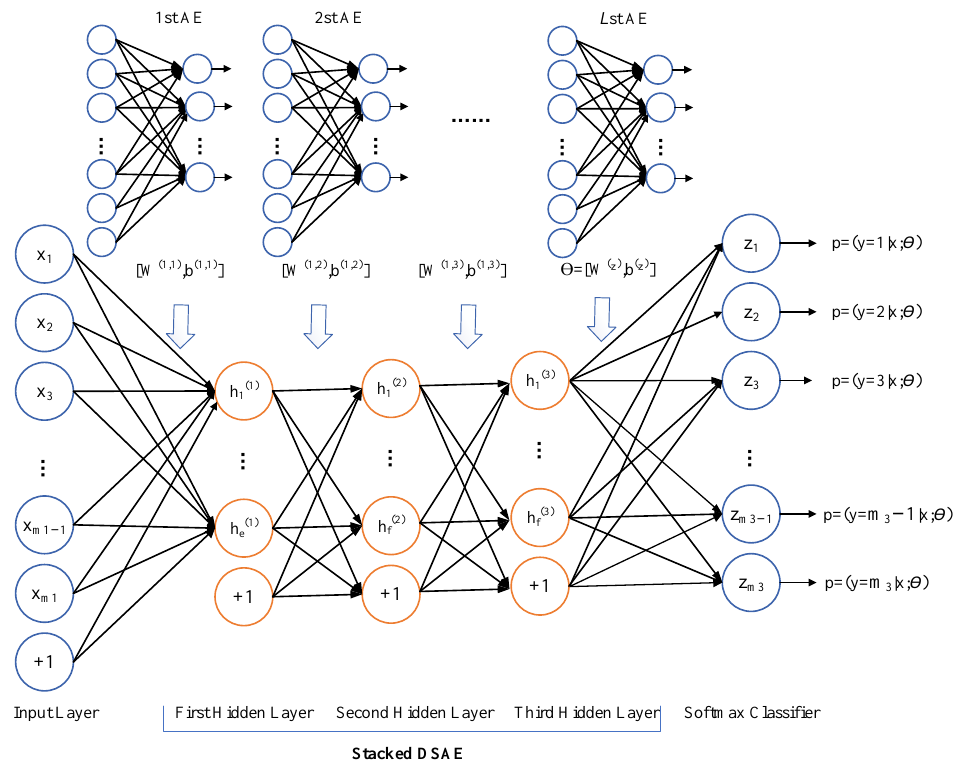
Figure 3. The proposed network architecture consists of 3 stacked DSAEs and a softmax